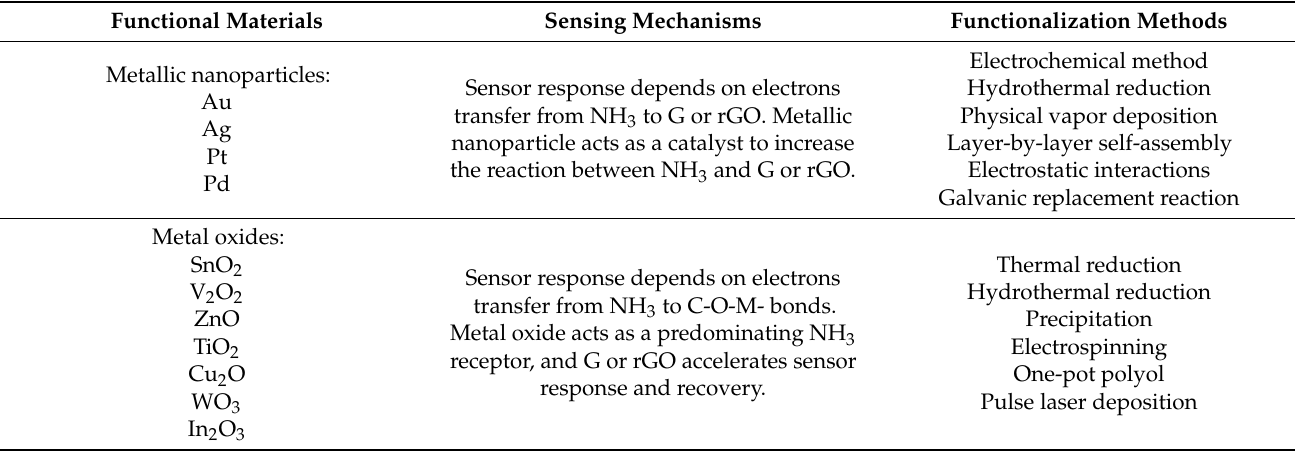
Table 2. Main sensing mechanisms of functionalized graphene NH 3 sensors and graphene functionalization methods based on metallic nanoparticles, metal oxides, organic molecules, and conducting polymers. Functional